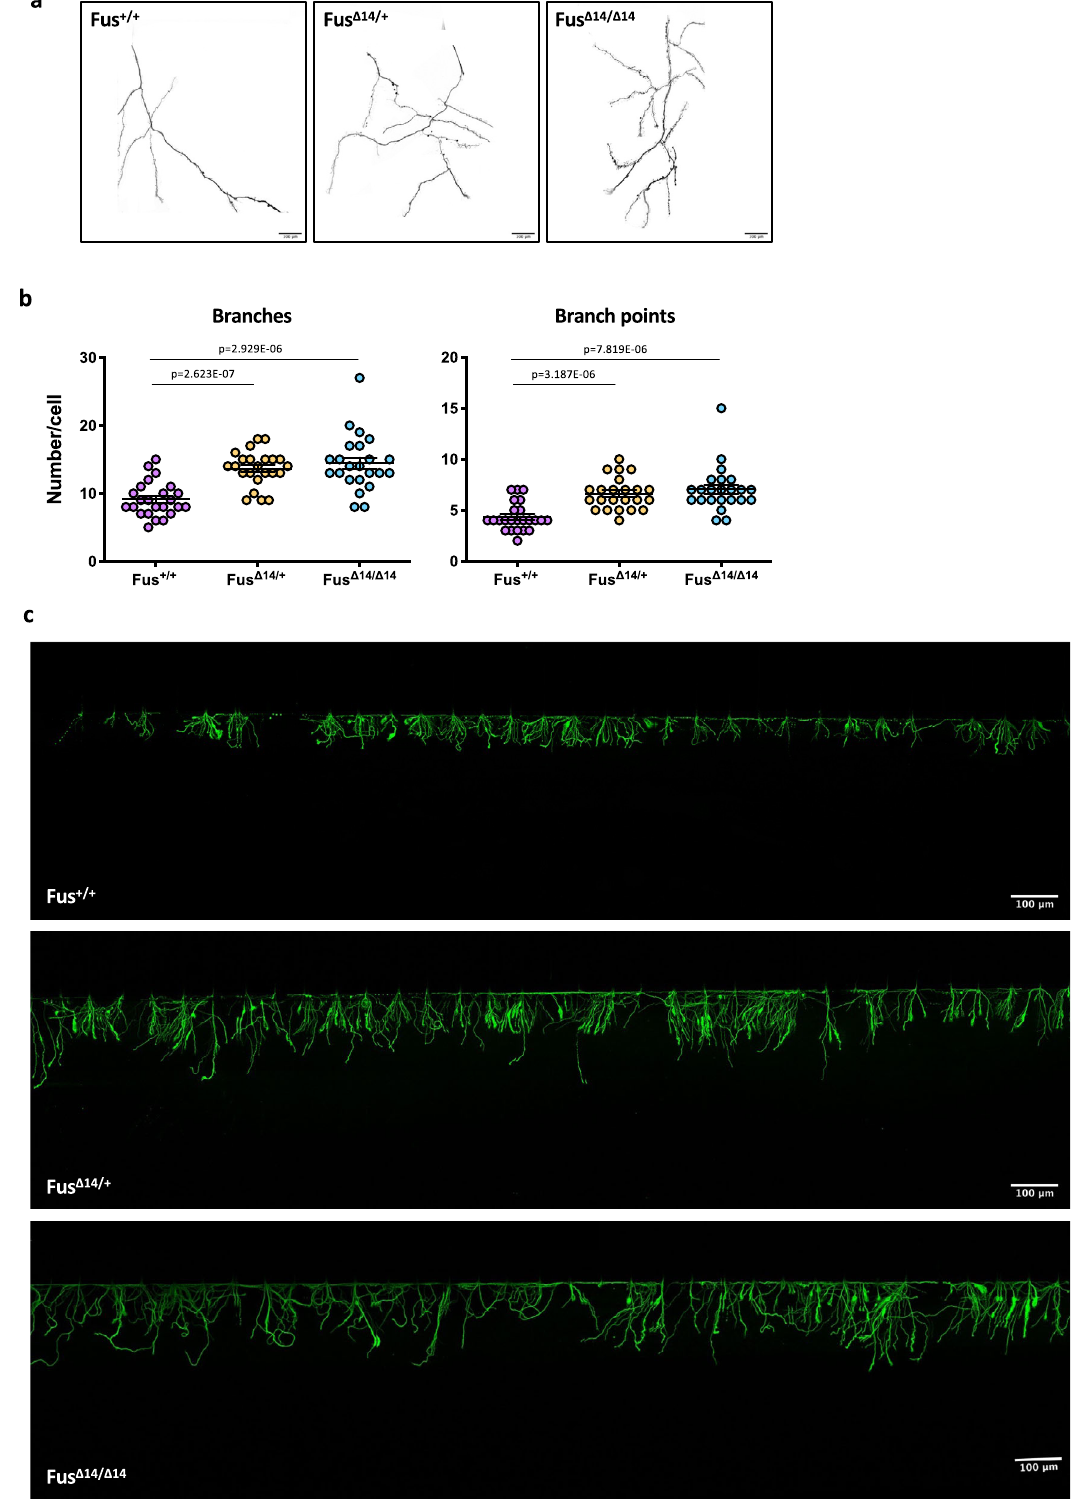
Fig. 5 Axonal phenotypes in primary spinal MNs from Fus- Δ 14 mouse models. a Representative images, generated with the Skeleton plugin of ImageJ, showing axons of Fus + / + , and heterozygous (Fus Δ 14/ + ) or homozygous (Fus Δ 14/ Δ 14 ) FUS mutant mouse primary MNs in the axon chamber of compartmentalized chips. Scale bar: 100 μ m. b Quantitative analysis of the number of axon branches and branch points in cells shown in a . The graphs show the average from three biological replicates, error bars indicate the standard error of the mean (Ordinary one-way ANOVA; multiple comparisons). c Immunostaining of Tubb3 (green) in Fus + / + , Fus Δ 14/ + and Fus Δ 14/ Δ 14 mouse primary MNs cultured in compartmentalized chips and allowed to recover for 30 h after trypsin treatment to induce axotomy in the axon chamber. Scale bar: 100 μ